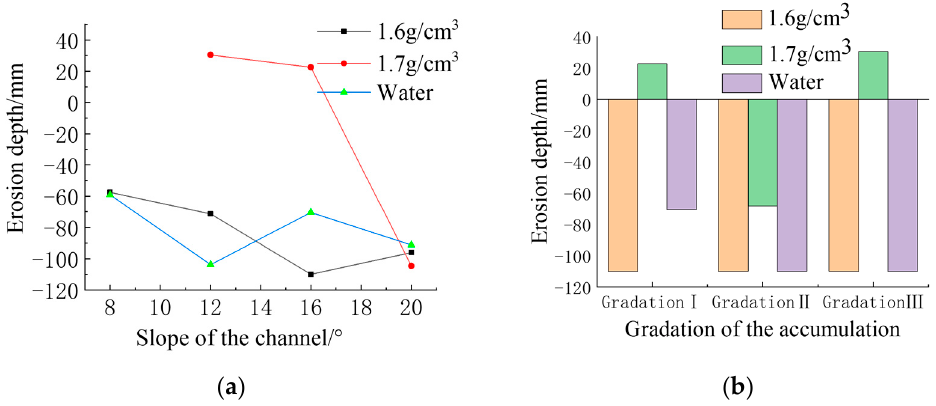
Figure 9. Lateral erosion depth. ( a ) Erosion depth under different slope gradients. ( b ) Erosion depth under different graded accumulations.